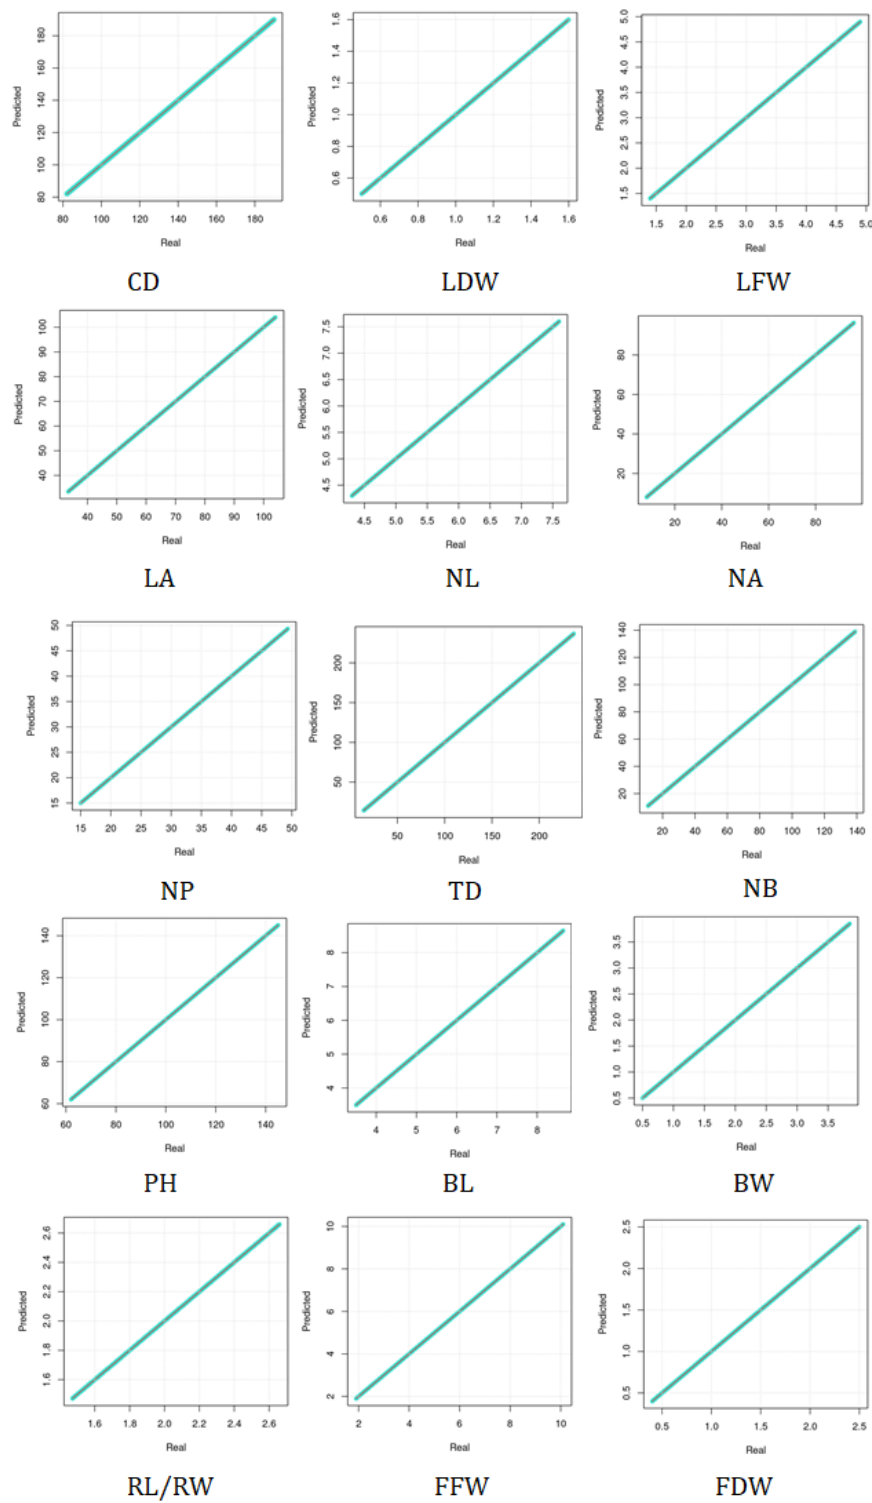
Figure 10. Scatter plots for the real versus predicted values of the 15 phenotypes of Taif rose. Canopy diameter (CD), leaf dry weight (LFW), leaf fresh weight (LFW), leaf area (LA), number of leaflets (NL), number of anthers (NA), number of petals (NP), trunk diameter (TD), number of branches (NB), plant height (PH), bud length (BL), bud width (BW), receptacle length/receptacle width (RL/RW), flower fresh weight (FFW), and flower dry weight (FDW).